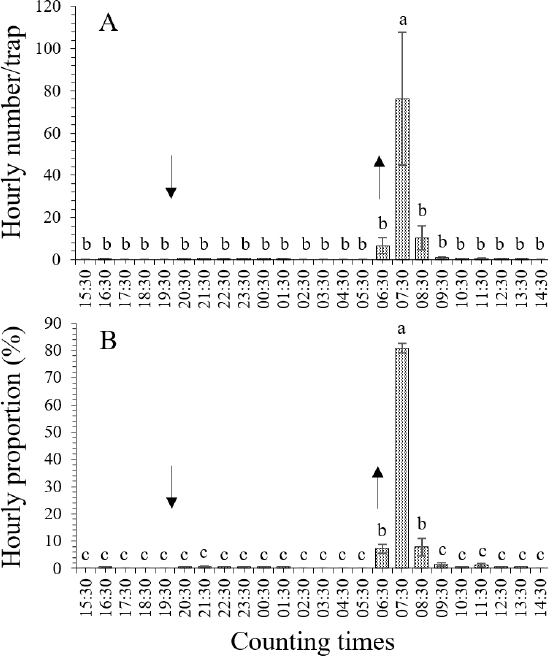
Figure 1. Hourly distribution of Tuta absoluta male adults responding to sex pheromone lures. Different lowercase letters indicate significant differences among different hourly periods at the p < 0.05 significance level (one-way ANOVA and LSD test). The up and down arrows indicate sunrise and sunset, respectively. ( A ), hourly distribution of numbers; ( B ), hourly distribution of proportions. The same applies in Figure 2 below.